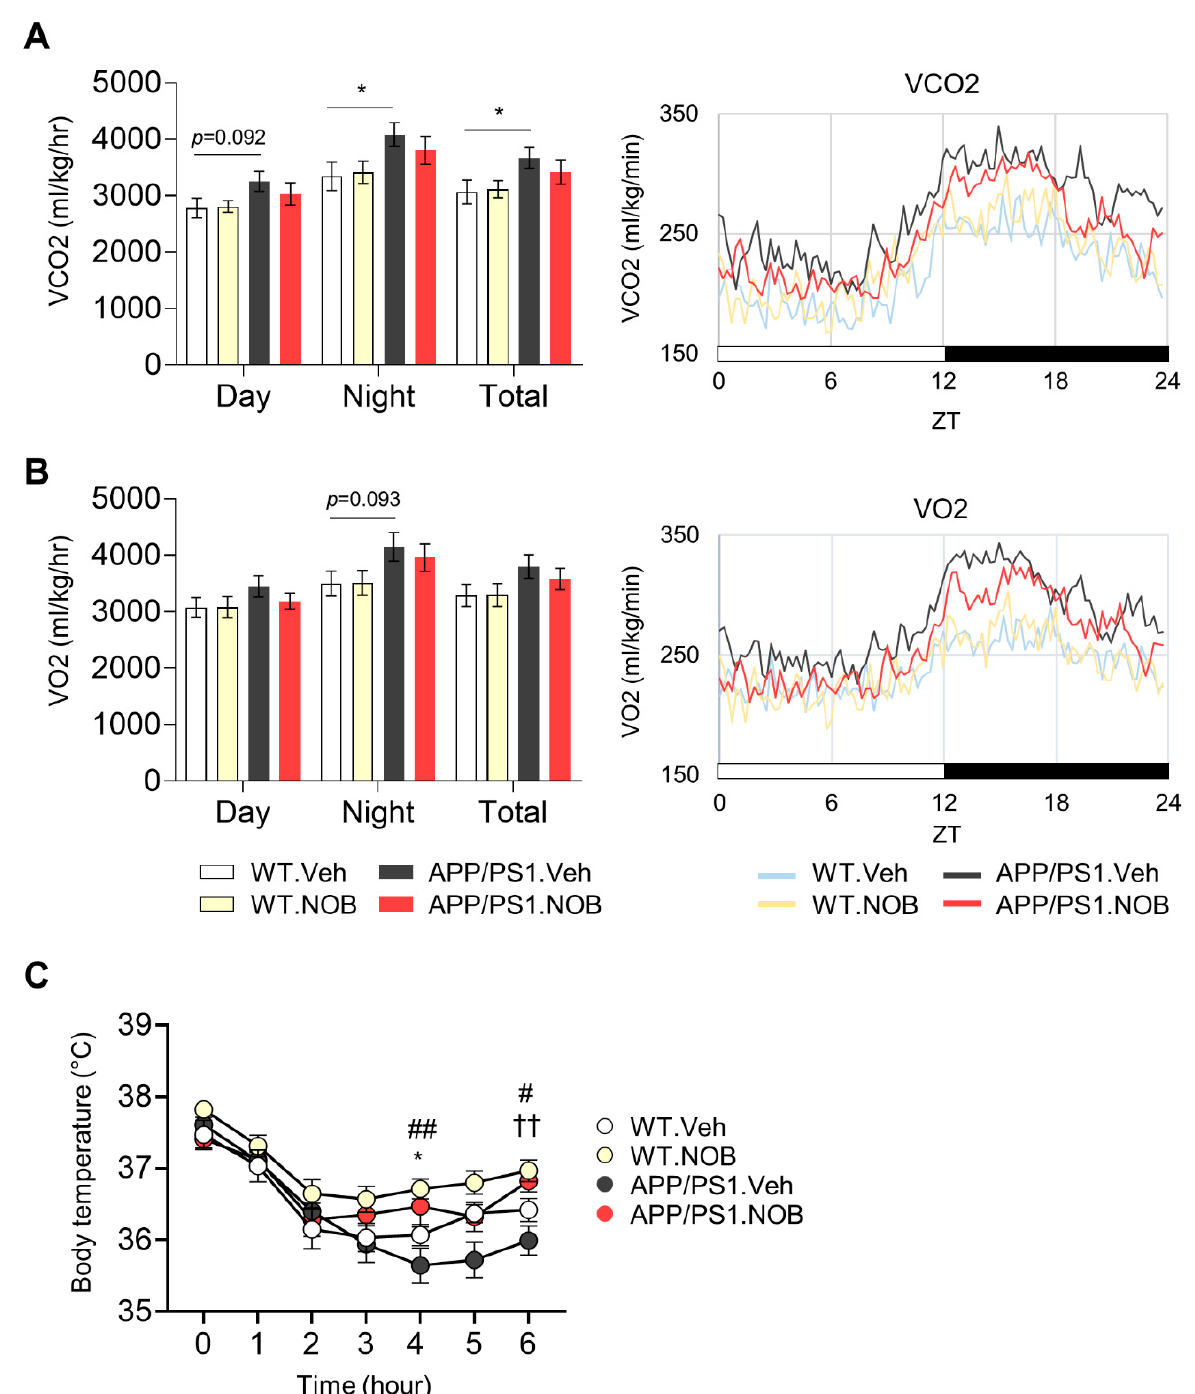
Figure 2. Nobiletin improves systemic metabolism in APP/PS1 mice. ( A, B ) Total average (left panels) and hourly average (right panels) of carbon dioxide production (VCO2) and oxygen consumption (VO2) using CLAMS metabolic chambers (n = 6–10/each group). Data represented by mean ± SEM. * p < 0.05 t -test. For the hourly average of VCO2: * p < 0.05 at the time points of 19.3 and 22.8 h, two-way ANOVA with Tukey’s multiple comparison test (APP/PS1.Veh vs. APP/PS1.NOB). For hourly average of VO2: * p < 0.05 at the time points of 13.5, 15, and 16.3 h, two-way ANOVA with Tukey’s multiple comparison test (WT.Veh vs. APP/PS1.Veh). ( C ) Cold tolerance test (n = 6–10/each group). Data represented by mean ± SEM. # p < 0.05, ## p < 0.01 unpaired student t -test (WT.Veh vs WT.NOB). * p < 0.05 unpaired student t -test (APP/PS1.Veh vs APP/PS1.NOB). †† p < 0.01 one-way ANOVA with Tukey’s multiple comparisons test (APPS/PS1.Veh vs. APP/PS1.NOB).